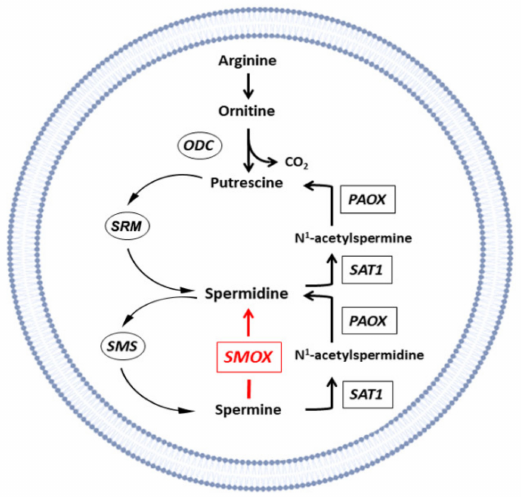
Figure 1. Enzymes involved in PA biosynthesis (encircled) and catabolism (boxed). ODC, or- nithine decarboxylase enzyme; PAOX, N1-acetylpolyamine oxidase; SAT1, spermidine/spermine N1-acetyltransferase; SMS, spermine synthase; SRM, spermidine synthase. The enzyme spermine oxidase (SMOX), which is overexpressed in the Dach-SMOX mice model, is highlighted in